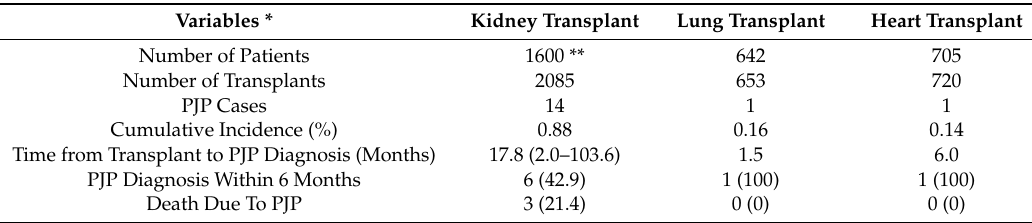
Table 4. Cumulative incidence of Pneumocystis jirovecii pneumonia in other types of solid organ